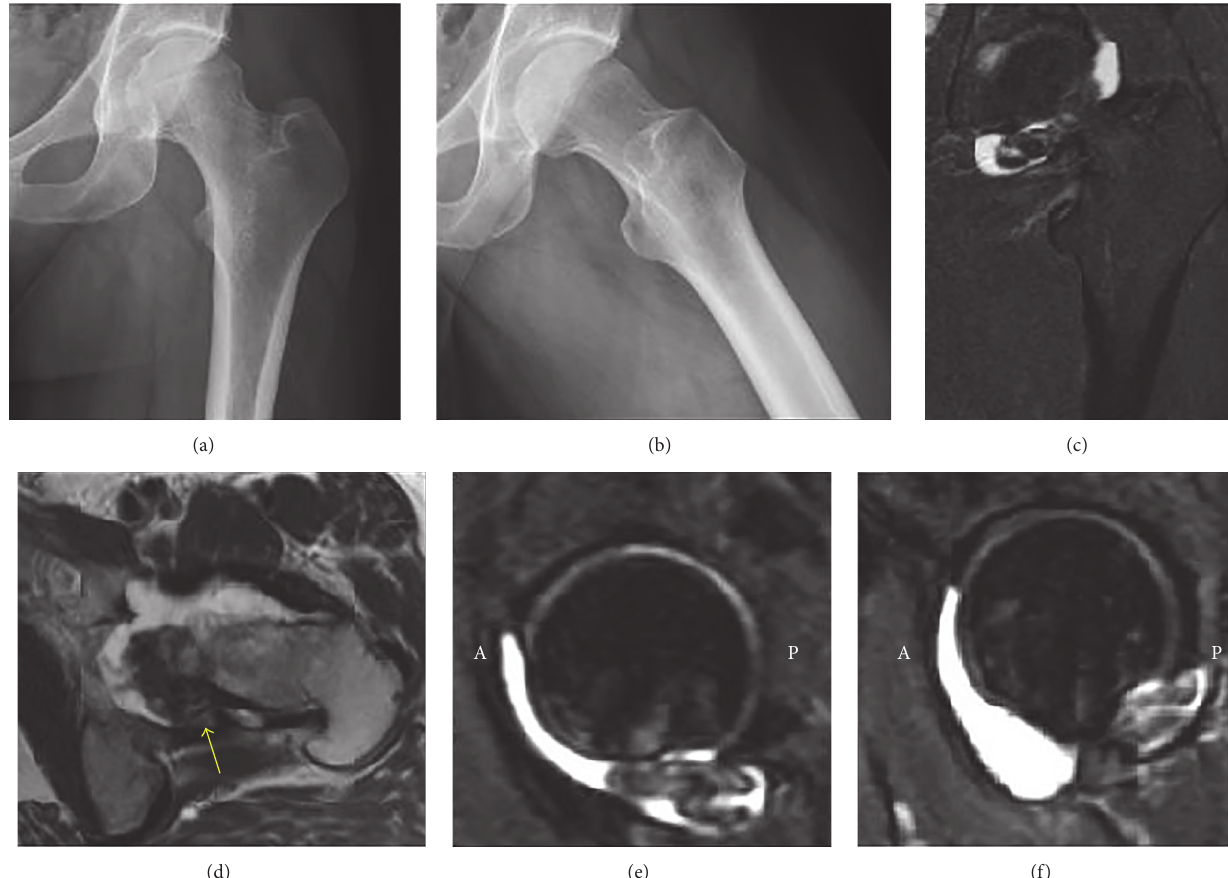
Figure 3: Preoperative anteroposterior (a) and frog-leg radiographs (b) of the left hip in Case 2 demonstrate a cam deformity. Preoperative coronal T2-weighted fat-saturated (c), axial T2-weighted (d), and sagittal T2-weighted fat-saturated (e, f) magnetic resonance sequences with intravenous contrast reveal a multilobulated low signal lesion (arrow in d) measuring approximately 4.0 × 1.1 × 3.4 cm within the posterior/inferior aspect of the hip joint, with an associated large joint effusion. A = anterior; P = posterior.